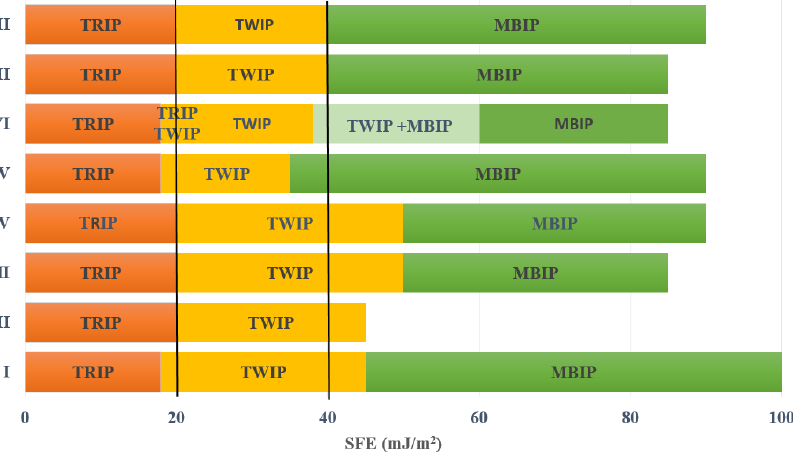
Figure 3. Deformation mechanisms of Fe-Mn-Al-C austenitic steel as a function of SFE where the vertical lines represent the deformation mechanism threshold. I [12], II [35], III [36], IV [37], V [22], VI [38], VII [5], VIII